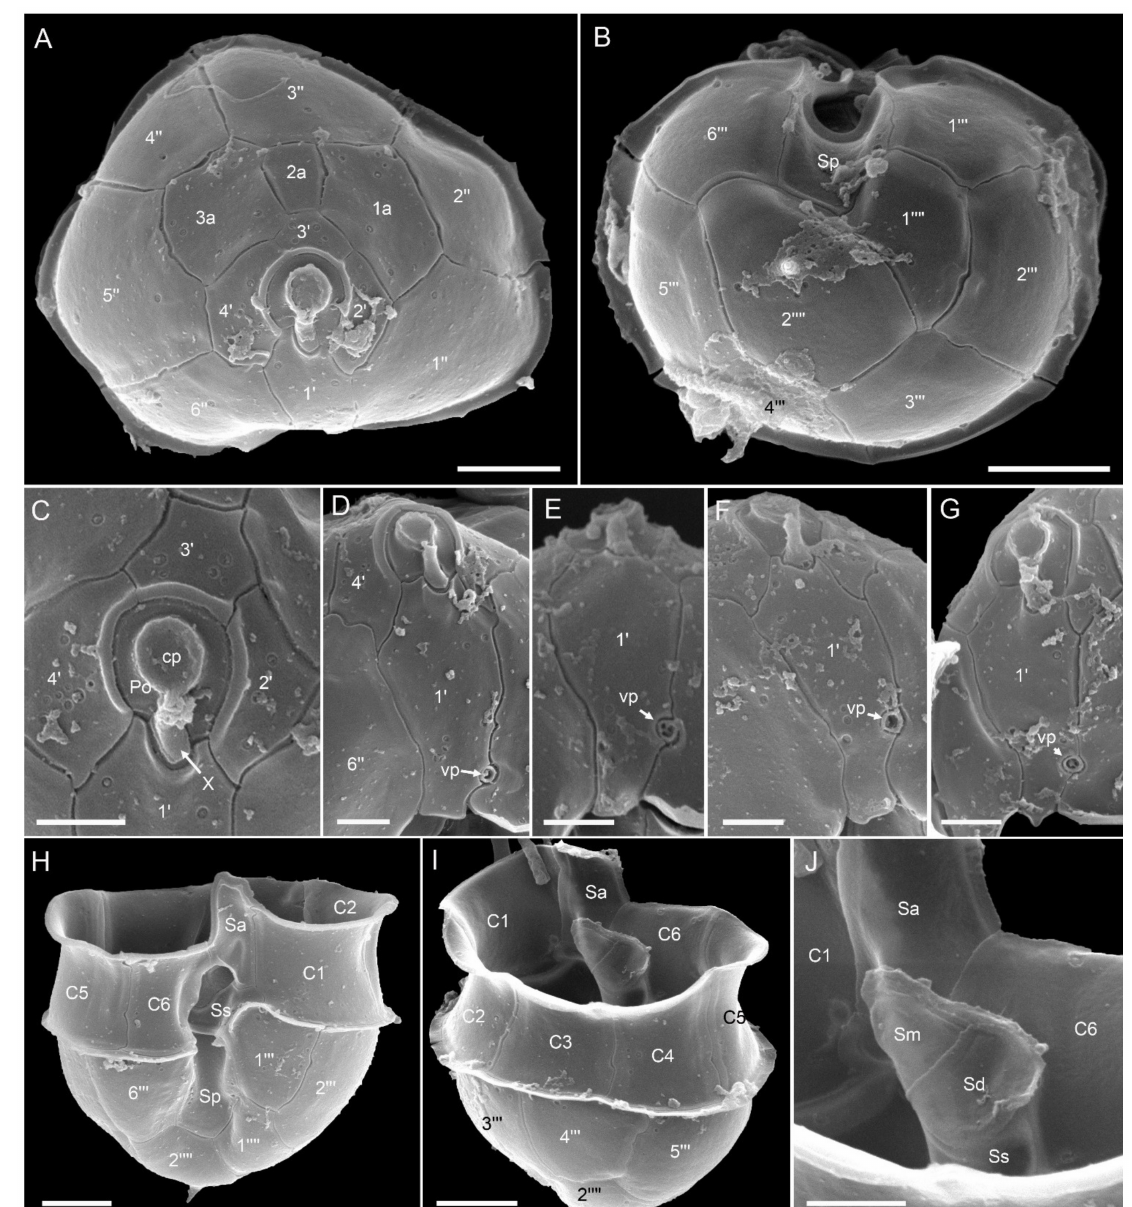
Figure 7. Azadinium cf. spinosum strain 5-B9. SEM images of different thecae. ( A ) Apical view of epithecal plates. ( B ) Antapical view of hypothecal plates. ( C ) Detailed view of the apical pore complex (APC). ( D – G ) First apical plate in ventral view. Note the position of the ventral pore (vp). ( H ) Hypotheca in ventral view. ( I ) Hypotheca in apical/dorsal view. ( J ) Detailed internal view of the sulcal plates. Plate labels according to the Kofoidian system. cp = cover plate; Po = pore plate; vp = ventral pore; X = X-plate or canal plate. Abbreviation of sulcal plates: Sa = anterior sulcal plate; Sd = right sulcal plate; Sm = median sulcal plate; Sp = posterior sulcal plate; Ss = left sulcal plate; Scale bars = 2 µ m ( A , B , H , I ) or 1 µ m ( C – G , J